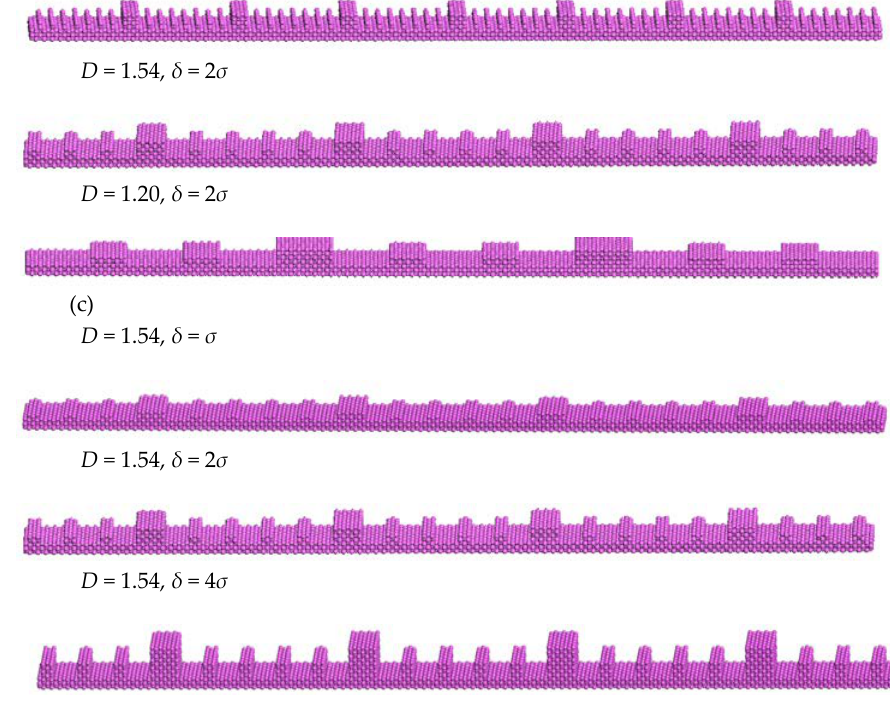
Figure 2. Electroosmotic flow in nanochannels: ( a ) Model of Electroosmotic flow; ( b ) Rough walls with different fractal dimension; ( c ) Rough walls with different rough height.